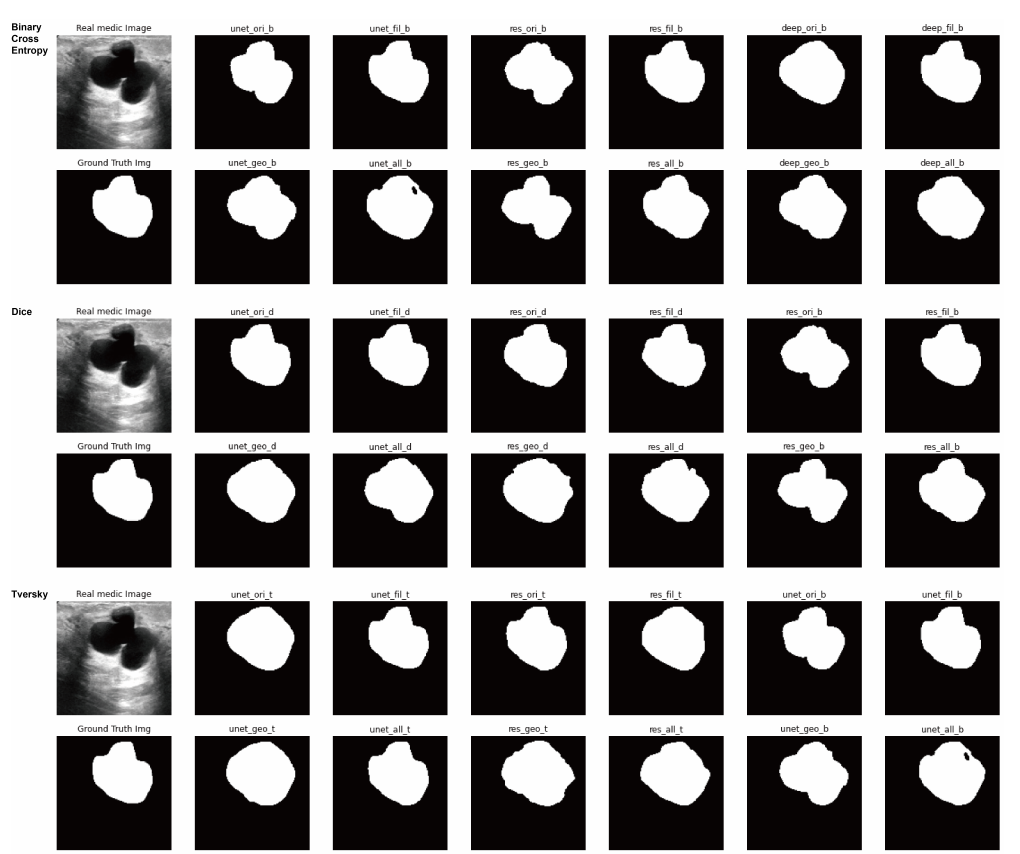
Figure 8. Result images for all combinations of the loss functions and the neural networks and the augmentation techniques in ultrasound